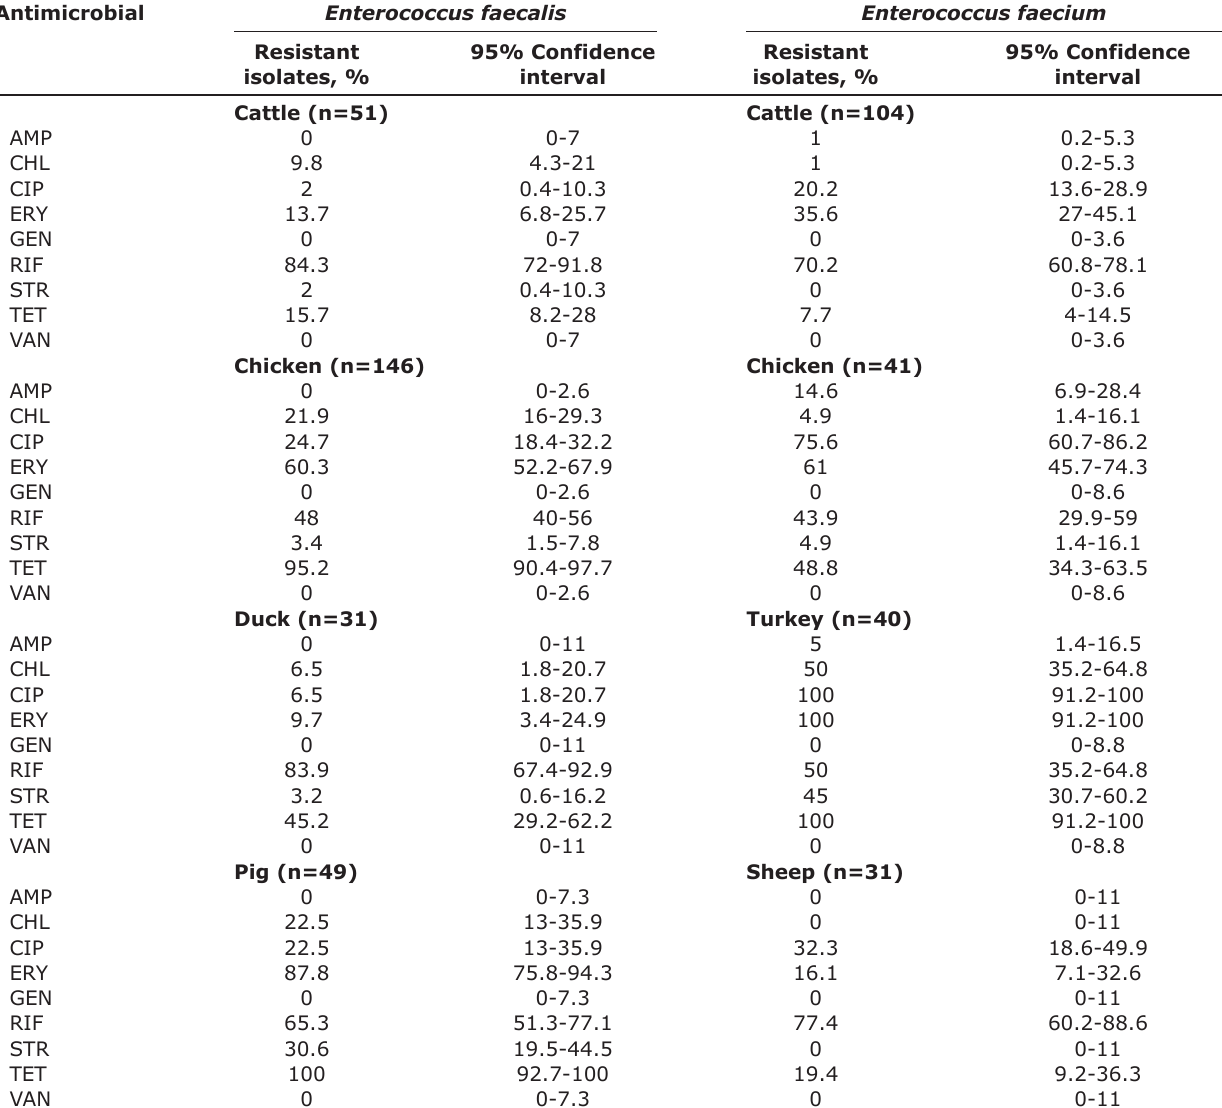
Table-4: Resistance patterns of enterococci isolates depending on the animal species (interpretation against CLSI 2021). Antimicrobial